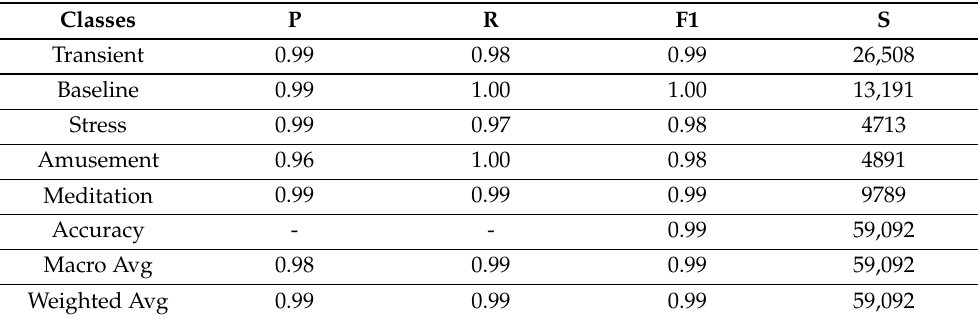
Table 3. Proposed model result of Client 1 for round 3. Key: Precision-P; Recall-R; F1-score-F1; S-Support.